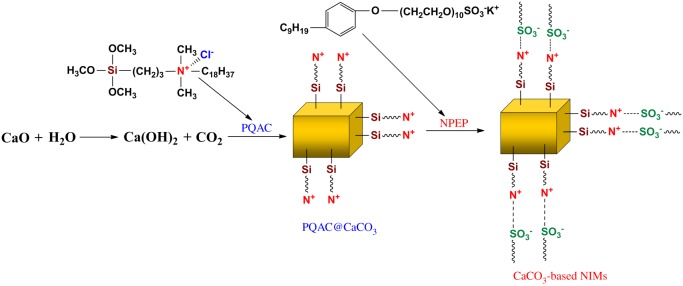
Schematic route for the synthesis of CaCO3-based NIMs.